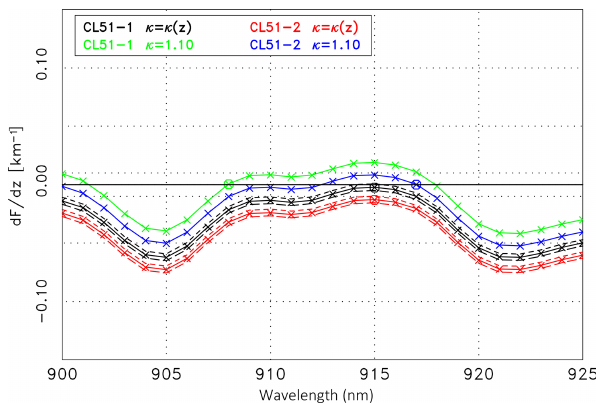
Figure 16. First derivative d F(z,λ on )/ d z (see Eq. 15), of the ra- tio of the CL51 ceilometer signal and the extrapolated reference lidar signal as a function of λ on : analogously to Fig. 12, but for 20 August 2015, 05:00–08:00UTC (Case B). The corresponding CL51 ceilometers and Angström exponent settings are indicated in the legend.